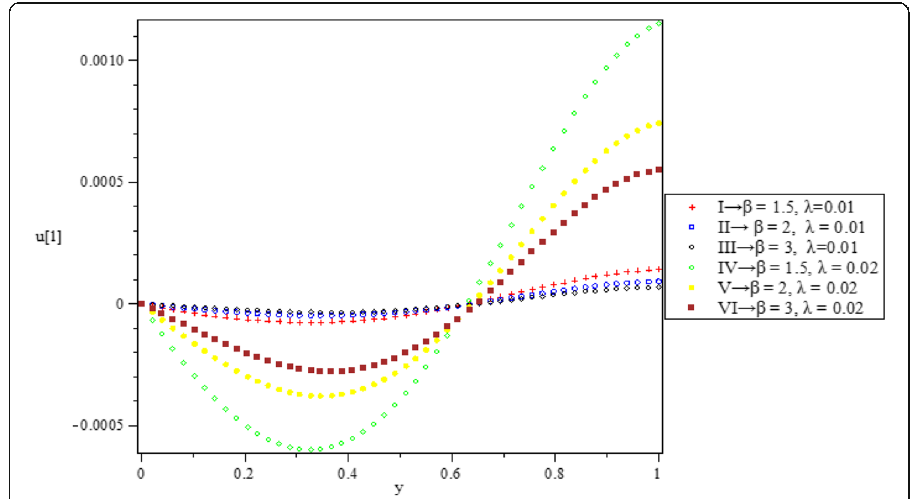
Fig. 18 First-order velocity (u[1] profile, r = − 1, ϵ = 0.25, P = 0.71 α = 5, and G =